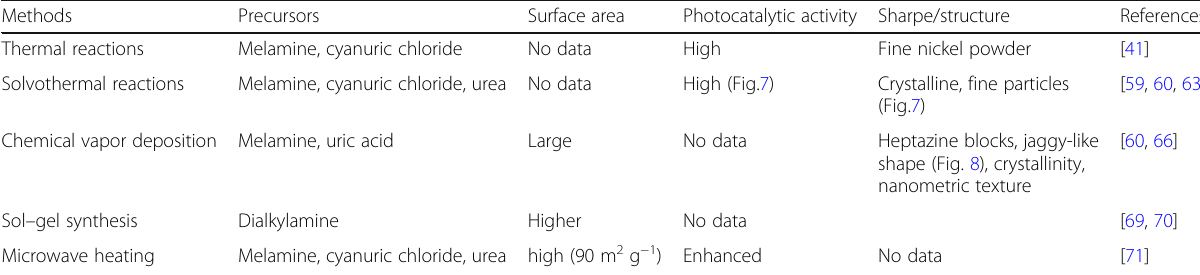
Table 2 Typical g-C 3 N 4 preparation